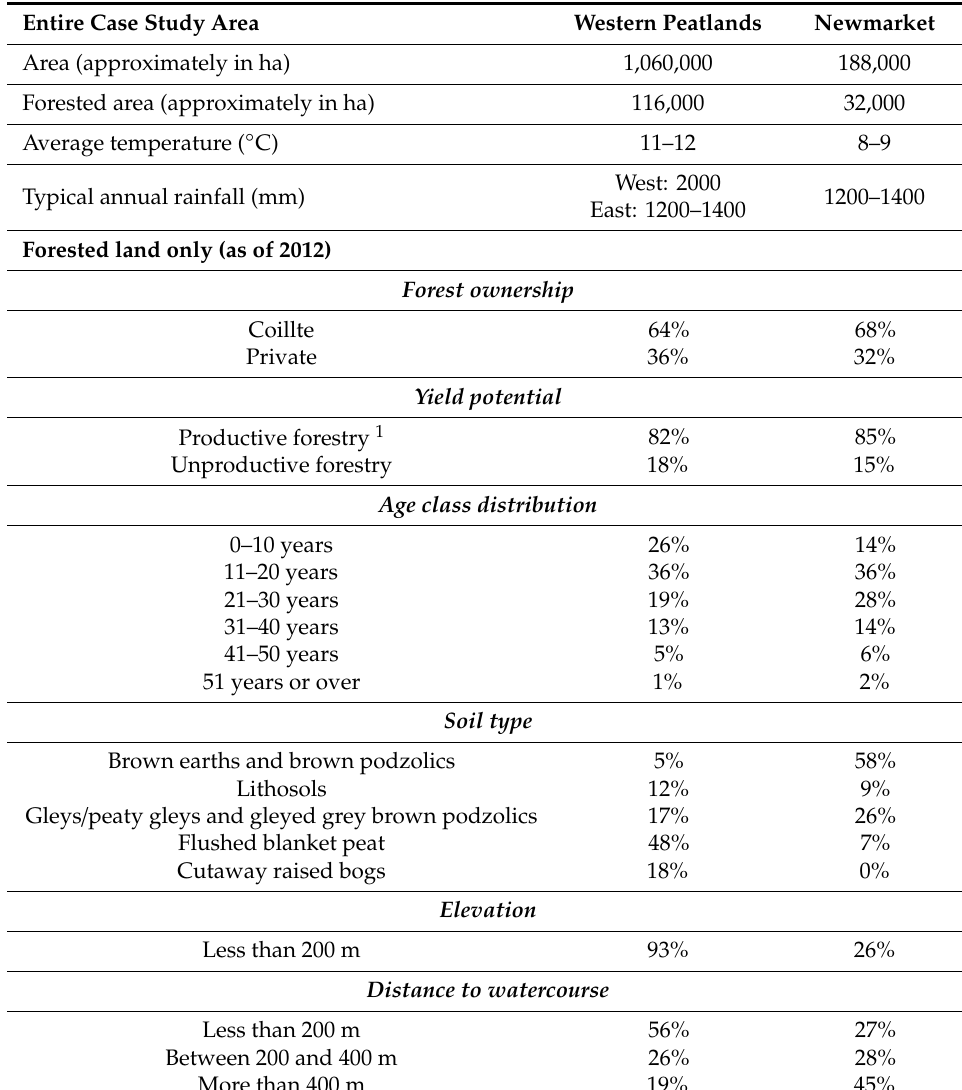
Table 1. Descriptive data associated with the WP and NM case study